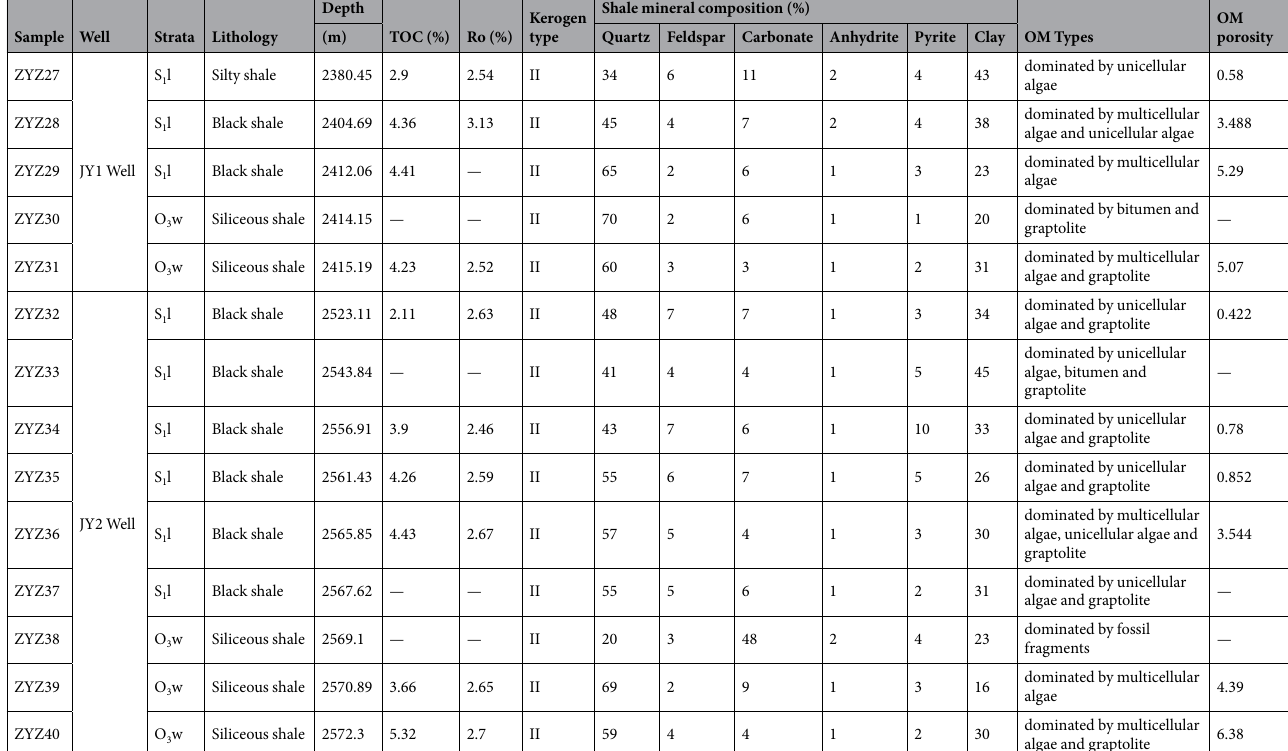
Table 1. Total organic carbon (TOC) content, mineral content and vitrinite reflectance (Ro) of samples. Note: The OM porosity equals to the volume percentage of TOC (twice the mass percentage of TOC) times the surface